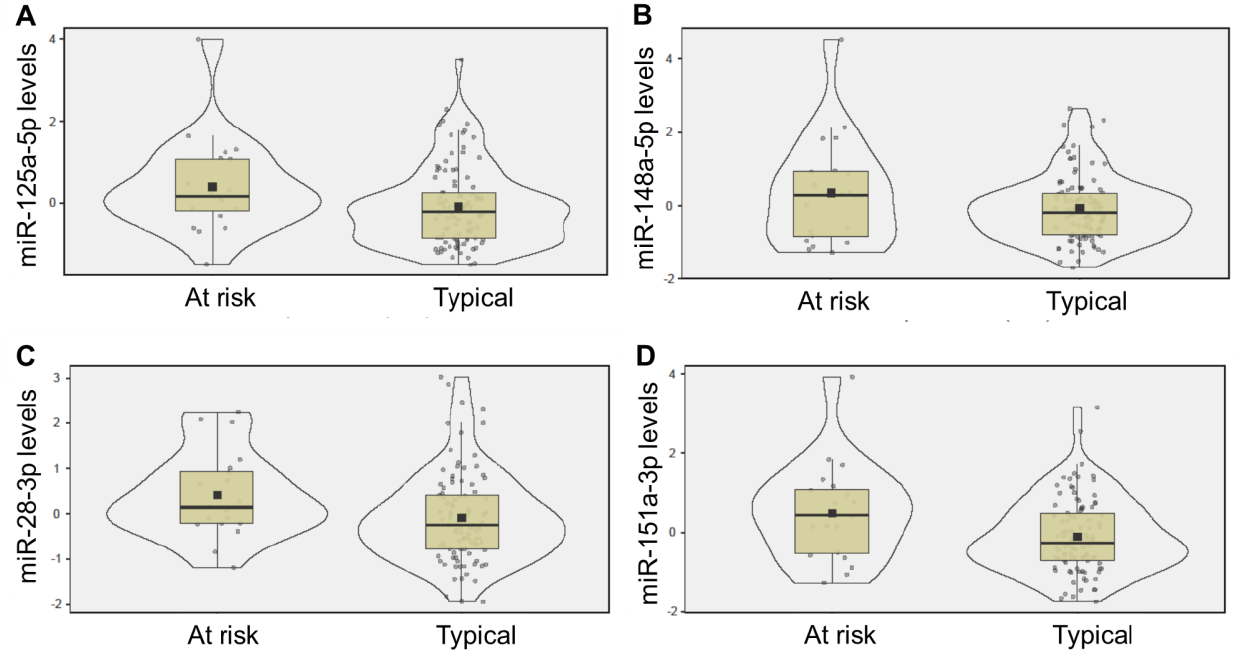
Figure 1. Saliva miRNAs levels display neurodevelopment-specific patterns in infants prior to clinical presentation of developmental concerns. The violin box plots display salivary levels of miR-